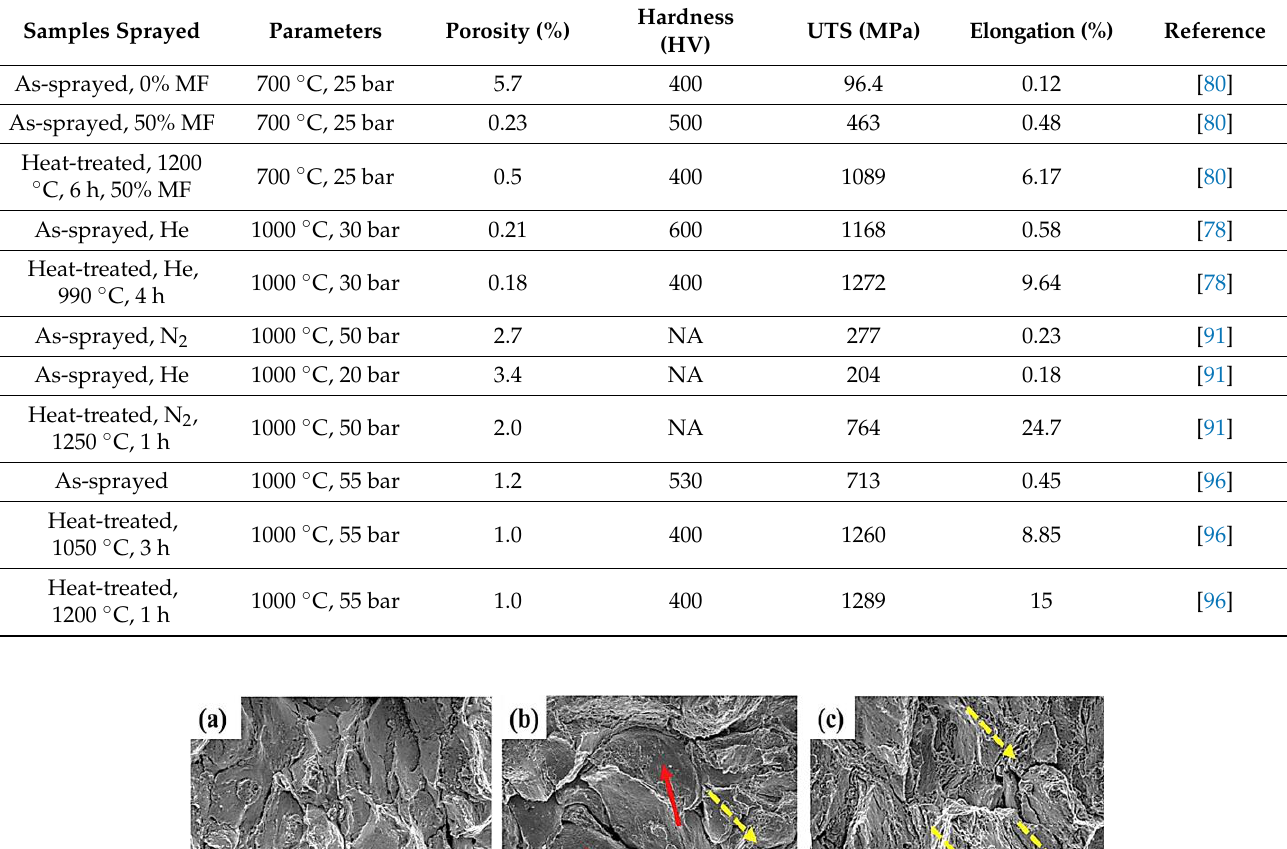
Table 2. A summary of changes in porosity, hardness, ultimate tensile strength (UTS), and elonga- tion between different cold-sprayed samples of IN 718 produced with N 2 and He (as the process gases), micro-forging (MF), and various heat treatments [78,80,91,96].